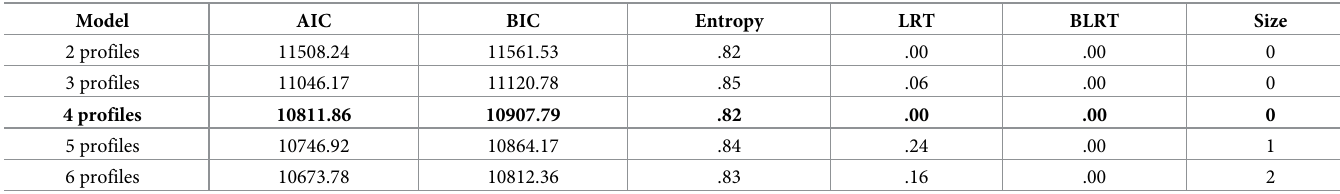
Note : Values in bold indicate best-fitting model. AIC = Akaike Information Criteria; BIC = Bayesian Information Criteria; LRT = Vuong-Lo-Mendell-Rubin Likelihood- Ratio Test; BLRT = Bootstrap Likelihood Ratio